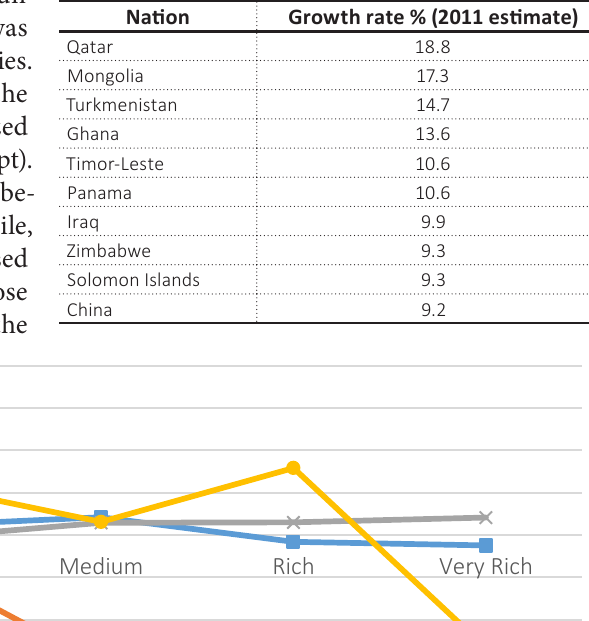
Table 11. The fastest-growing nations in the world